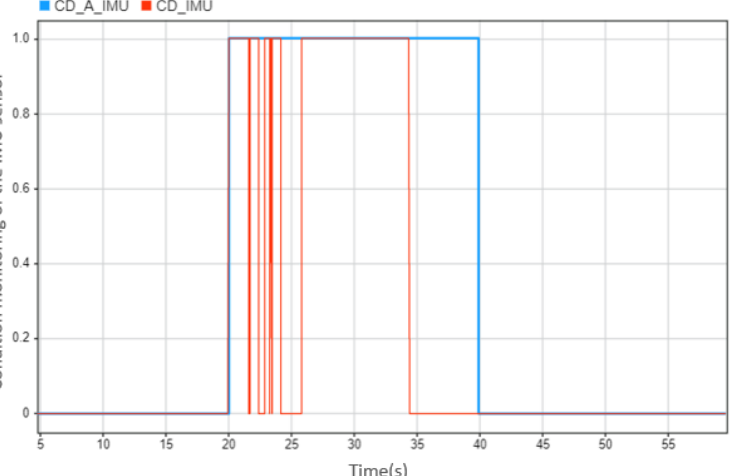
Figure 21. The diagnostic result of condition monitoring of IMU sensor: the case is that the IMU sensor fails between 20 s and 40 s, but the diagnostic result shows the failure is only between 20 s and 34.4 s (“CD” is an abbreviation for “condition”, “0” refers the normal state, “1” refers the faulty state, the blue line refers to the real state of the IMU sensor, the red line refers to the diagnostic state of the IMU